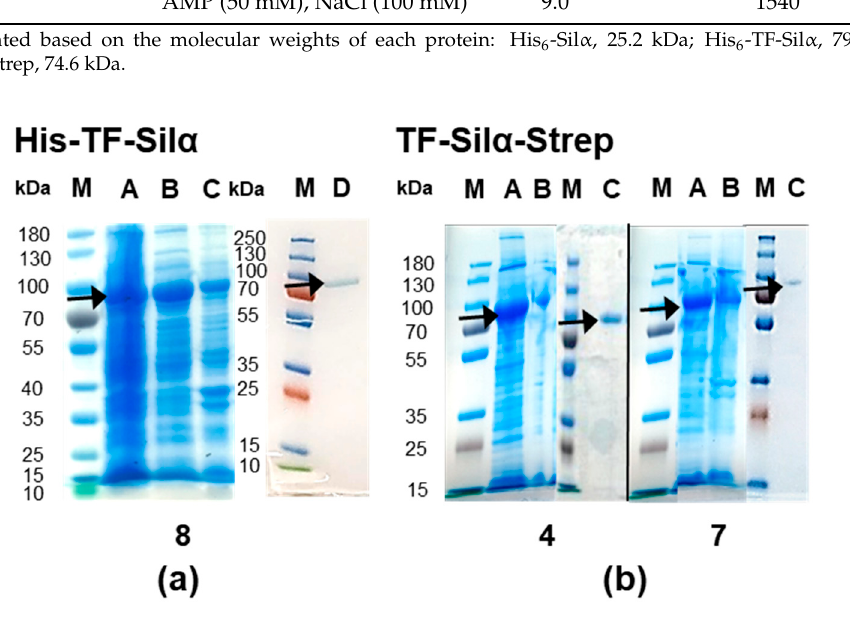
a Calculated based on the molecular weights of each protein: His 6 -Sil α , 25.2 kDa; His 6 -TF-Sil α , 79.1 Table 4. Comparative summary of protein production yields for the Sil α fusion proteins. kDa; TF-Sil α -Strep, 74.6 kDa. Protein